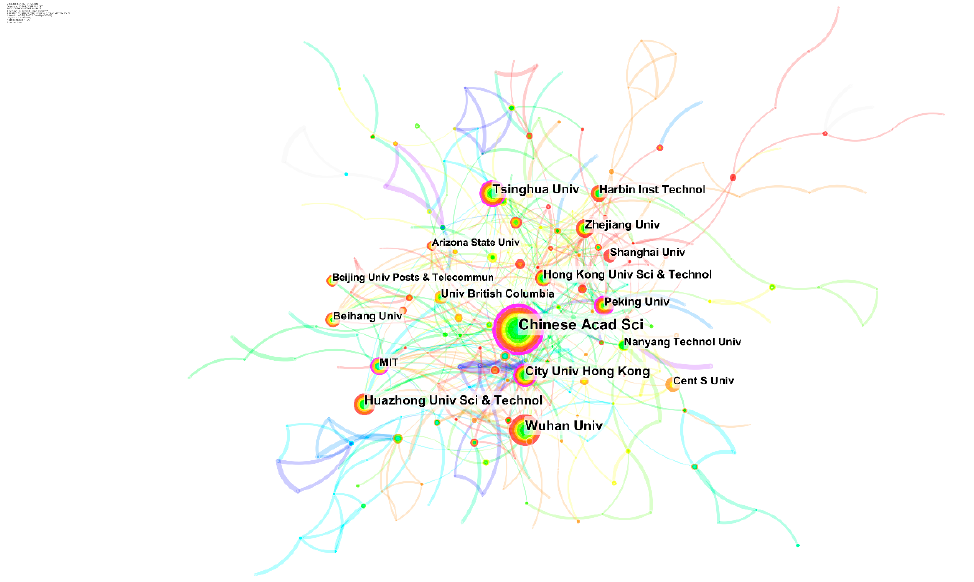
Figure 4. Knowledge map of institution collaboration in SMBD.